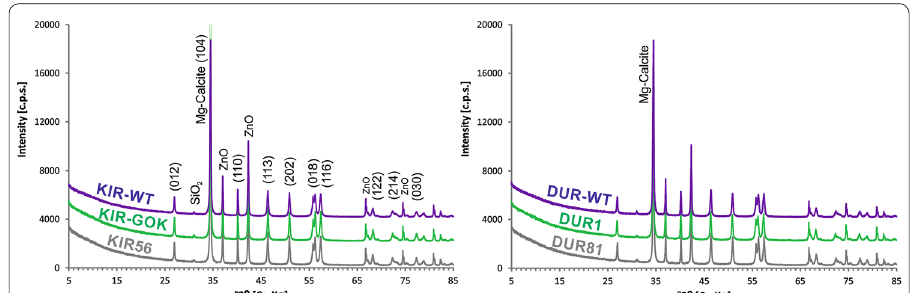
Fig. 2 Mineralogical composition of KIR and DUR scale-fragment samples based on powder X-ray diffraction (XRD) spectra. The samples were recovered from heat exchangers (KIR-WT, DUR-WT), close to the wellhead (KIR-GOK, DUR1), or from pipes installed several hundred meters deep in the borehole (KIR56, DUR81). All samples measured are almost exclusively composed of Mg-calcite. Zincite (ZnO) was used as an internal standard. In the left XRD pattern, the determining crystal planes (Miller Indices) of Mg-calcite are indicated